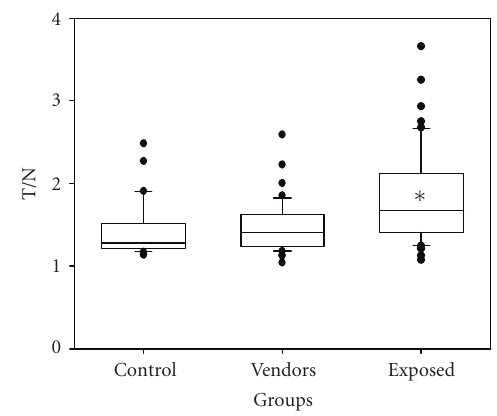
Figure 1: Box plot of the T/N index values obtained in the lympho- cytes of the studied groups. Each box encloses 50% of the data with the median value of the variable displayed as a line. The height of the box is the interquartile range (IQR) of the variable population. The lines from the top and the bottom of each box mark the ± 1 . 5 IQR value. The outliers are displayed as individual points. ∗ Statistically significant di ff erence with respect to control and vendors groups. Kruskal Wallis test (P < .